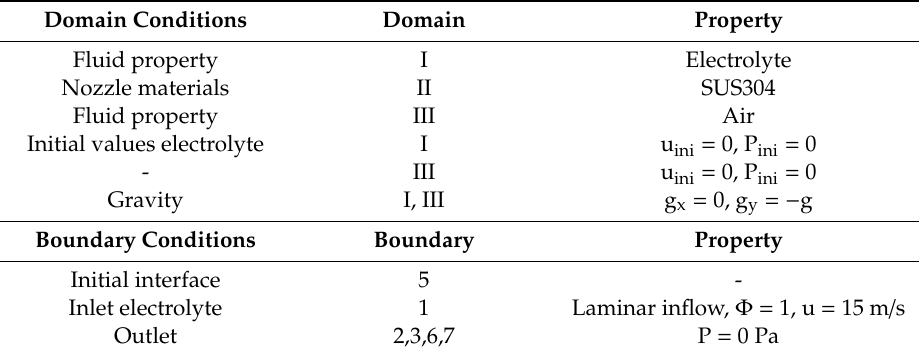
Table 1. Domain and boundary conditions for the simulations of fluid dynamics.